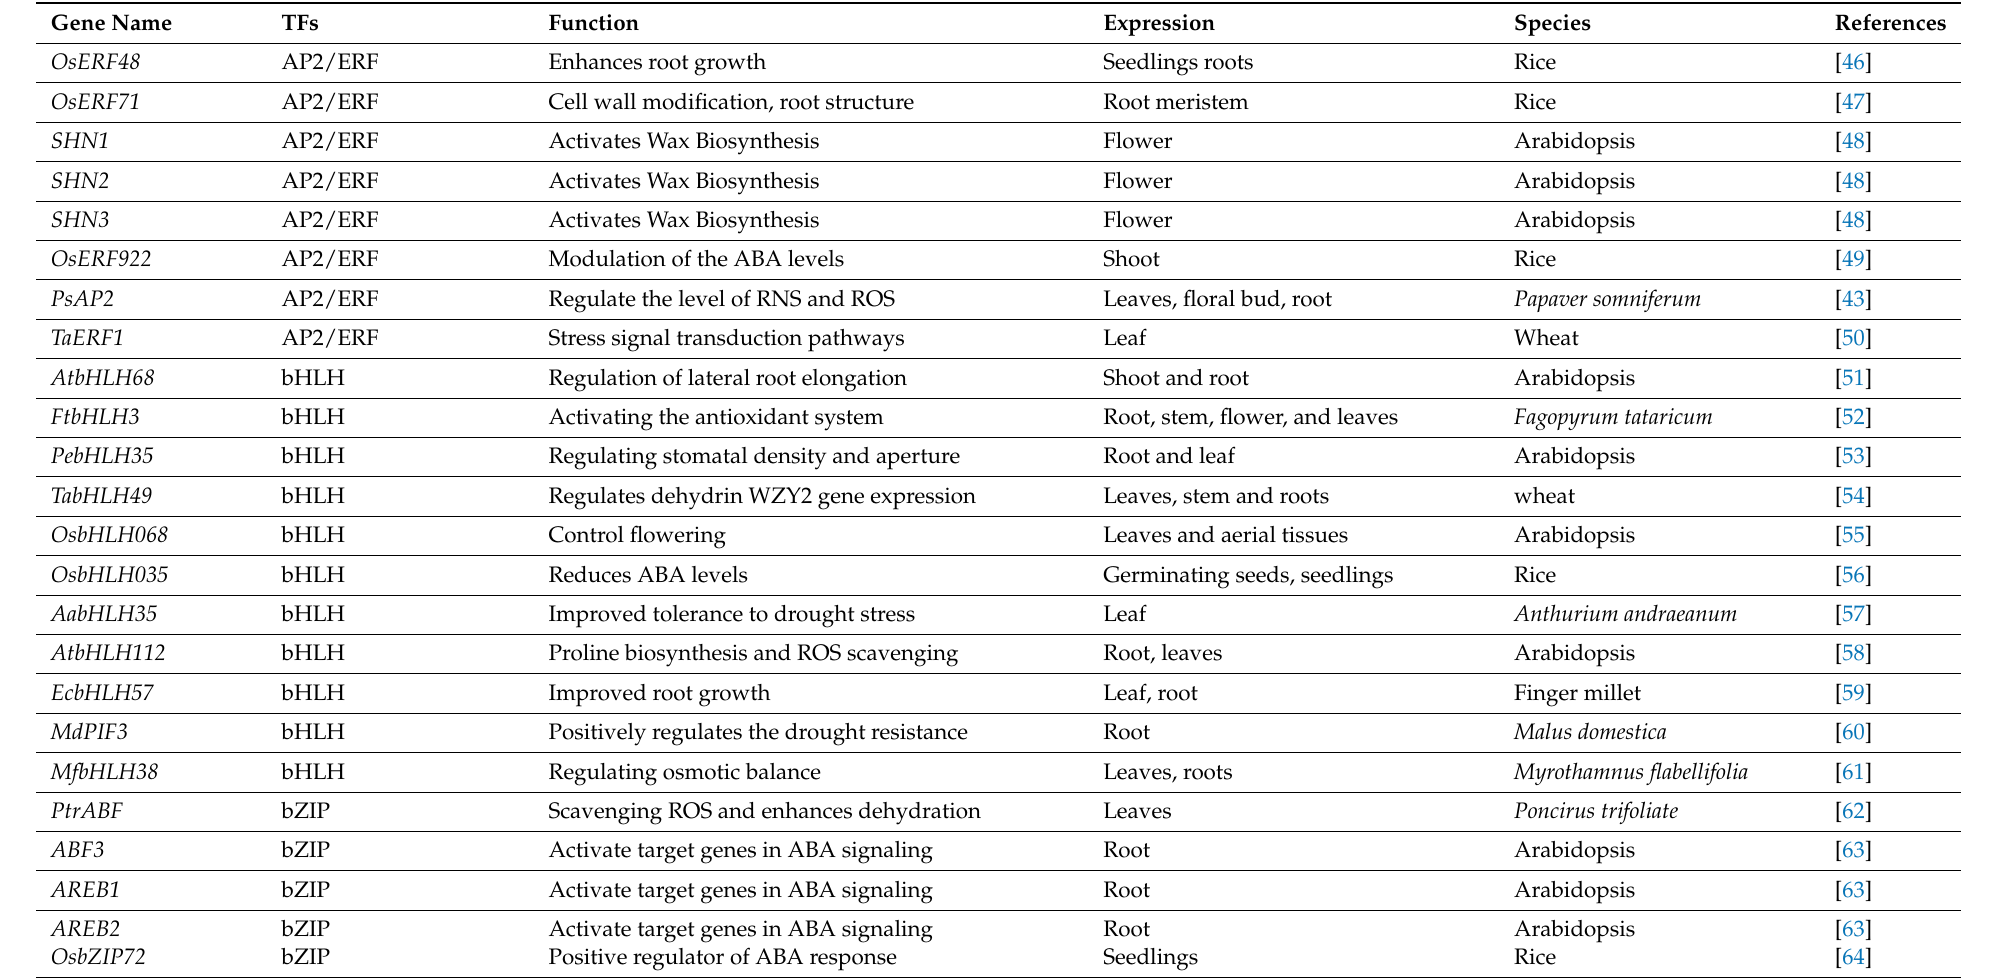
Table 1. The genes involved in drought and salinity stress tolerance in different